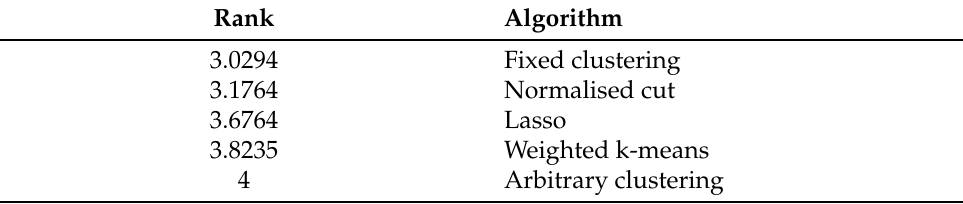
Table 5. Friedman results of the proposed methodology using different feature selection techniques for precision.